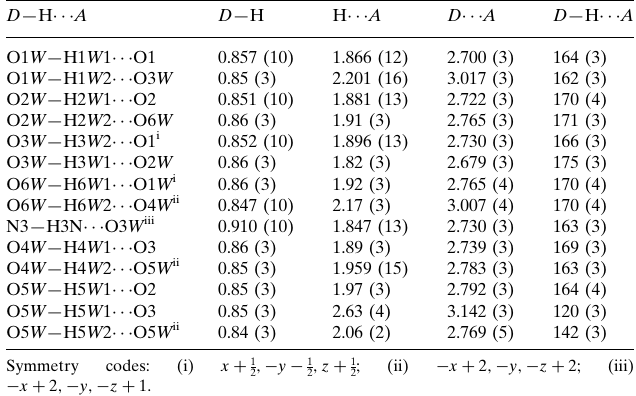
Hydrogen-bond geometry (A˚ , (cid:2)